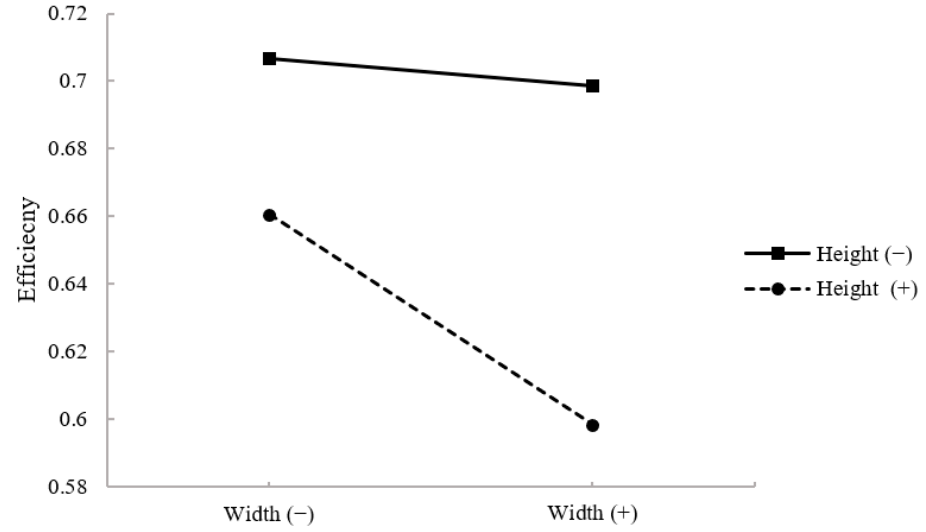
Figure 14. Interaction between width and height in the DOE study. The ( − ) and (+) refer to changes to the original dimension of − 7% and +7%, respectively.